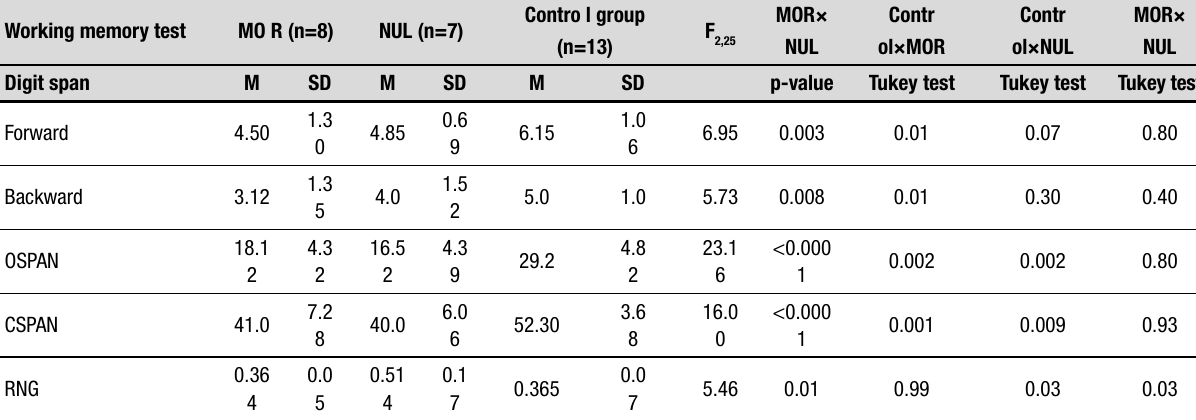
Table 4. Performance in working memory task of amnesic subgroups (MOR and NUL) and control group. Working memory test Digit